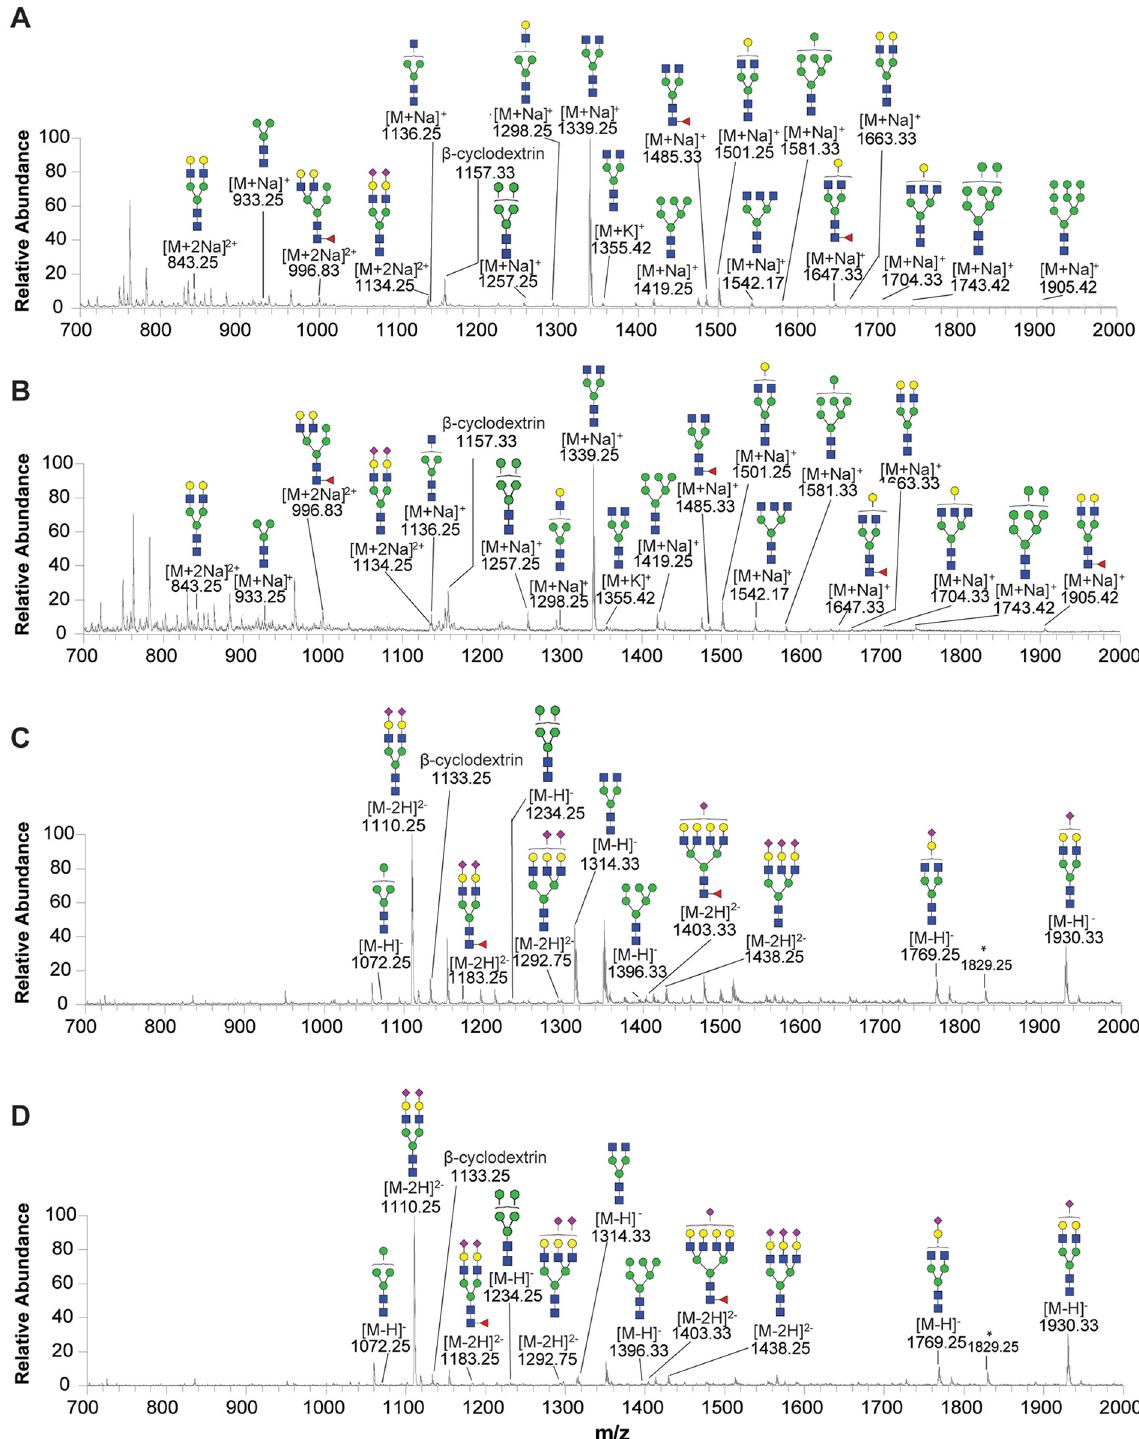
Fig 5. ESI-MS profiles of the plasma N-glycans released from rabbits. Representative N-glycan profiles of the whole plasma from either normal (A and C) or hypercholesterolemic rabbits (B and D). A and B show mass spectra of N-glycans in positive-ion mode; and C and D show mass spectra in negative-ion mode. Structural formulas: blue square, N-acetylglucosamine; green circle, mannose; yellow circle, galactose; red triangle, fucose; purple diamond, N- acetylneuraminic acid.